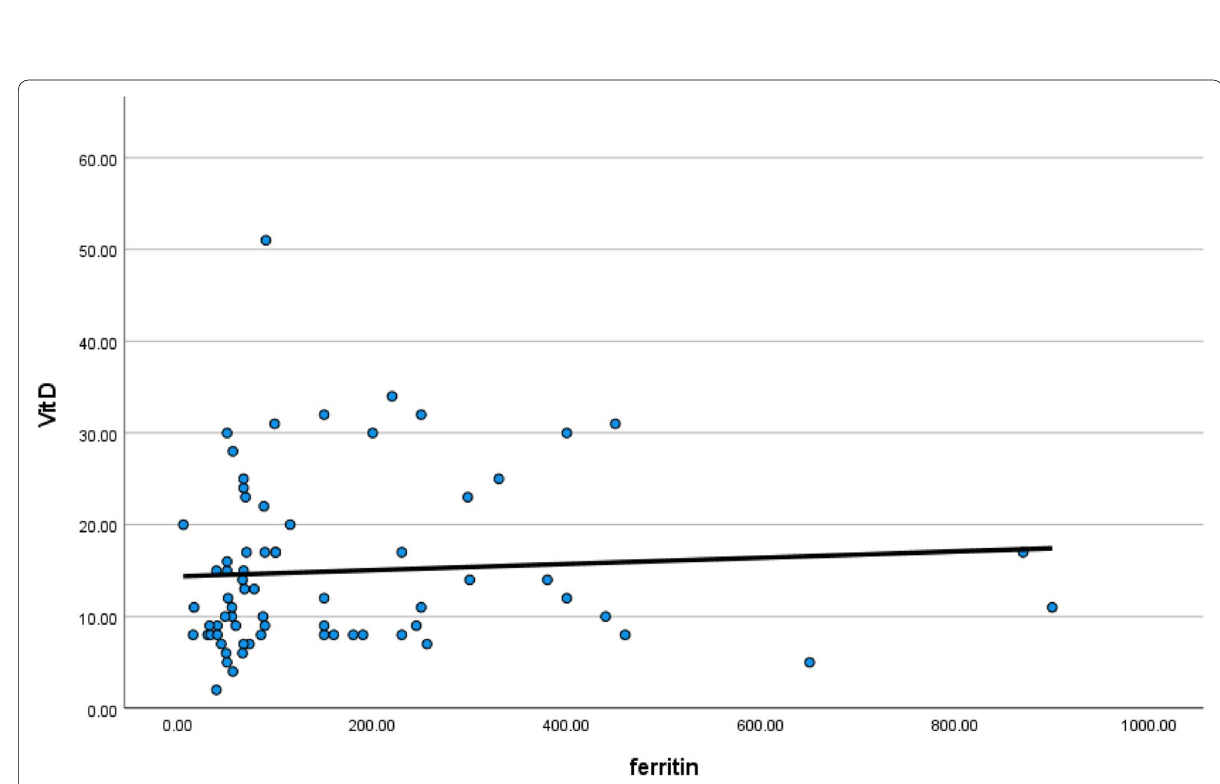
Fig. 23 Correlation between serum vitamin D and serum ferritin level in COVID 19 patients (symptomatic and